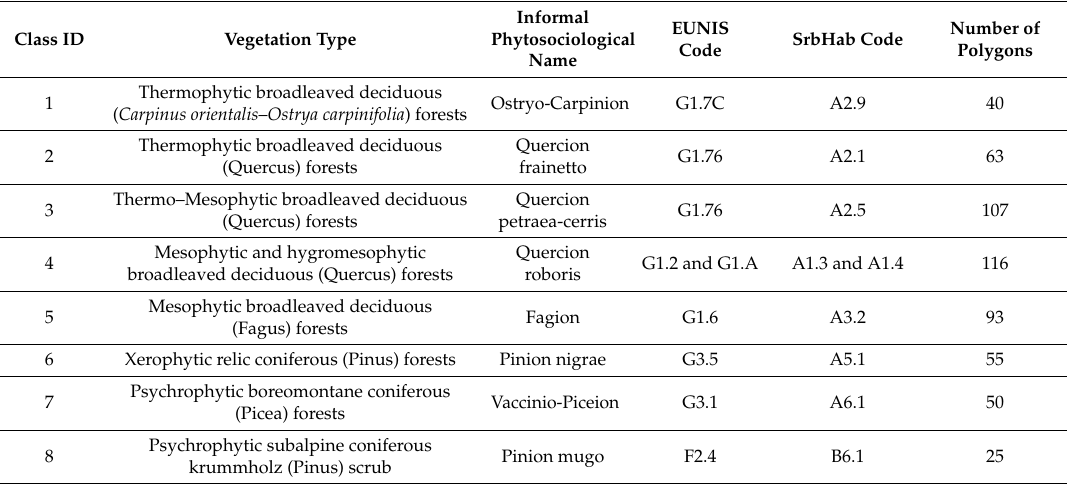
Table 1. The definition of classification scheme and the number of vectorized training polygons for their